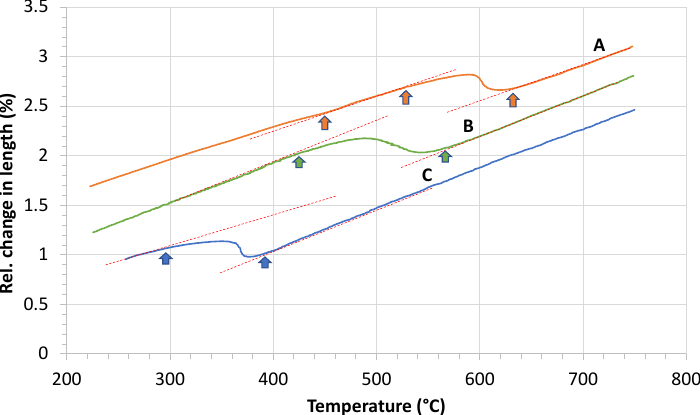
Figure 6. Austenite decomposition kinetics in terms of relative change in length during cooling of alloys A, B and C according to schedule I. The marked temperatures on the curves of alloys A and B designate the A r1 and A r3 temperatures and on the curve of alloy C designate the martensite start (M S ) and martensite finish (M f ).